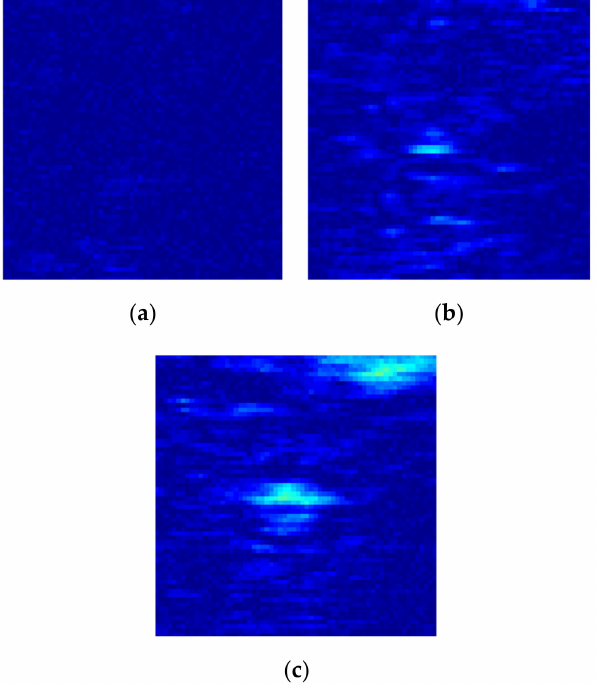
Figure 5. Subtractionimagesofirradiationarea. ( a )Normaltissue; ( b )Damagedtissue; ( c ) Denatured